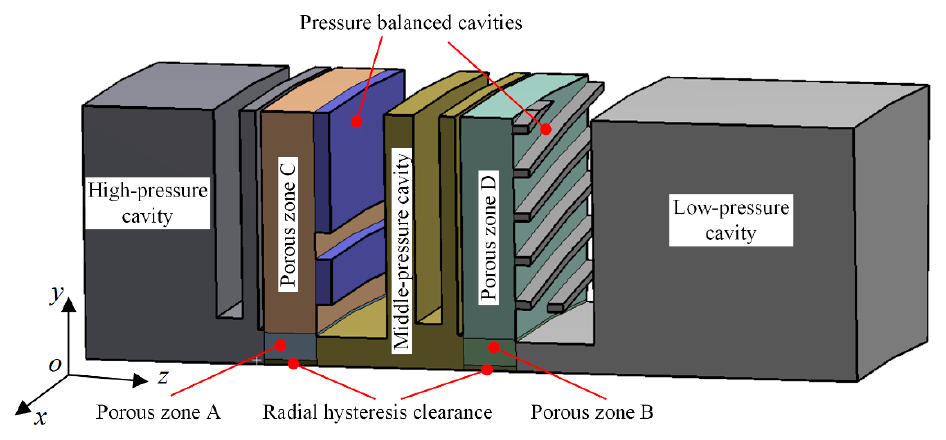
Figure 4. Schematic diagram of the CFD model of 2SFS.